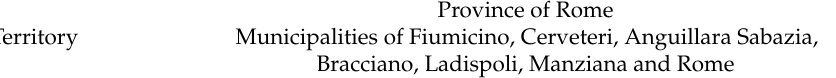
Table 2. The River, Coastal, and Landscape Contract Arrone. Source: authors’ elaboration (2022) from data from the official web site of the contract available at https://contrattodifiumearrone.it/ documentazione-progettuale/ (accessed on 20 July